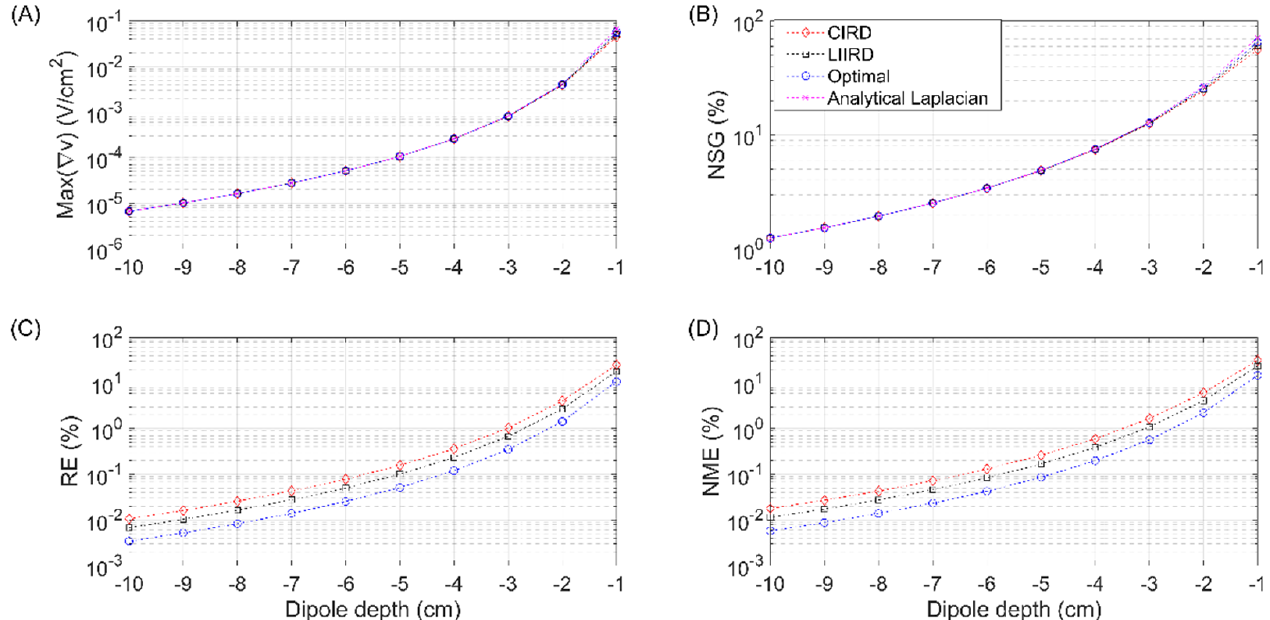
Figure 5. Maximum Laplacian amplitude (Max( ∇ v )), normalized spatial gradient (NSG), relative (RE), and normalized maximum errors (NME) computed via the finite element method modeling for a tripolar concentric ring electrode with a diameter equal to 3 cm and dipole depths ranging from 1 to 10 cm.